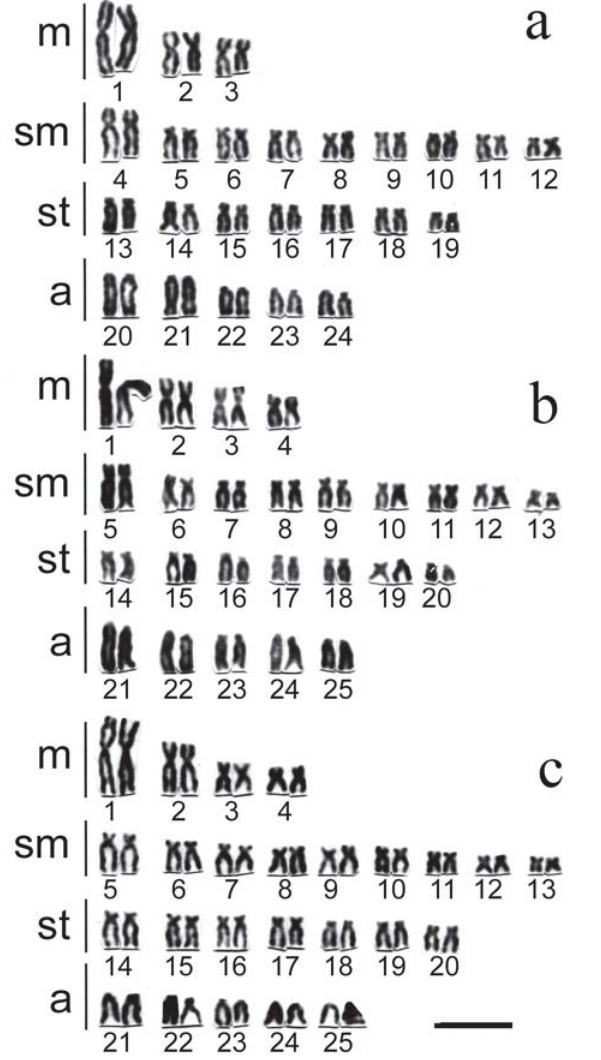
Fig. 2. Conventional karyotypes found in Astyanax aff . fasciatus of the upper rio Tibagi region (Ponta Grossa, Paraná State, Brazil). In (a), cytotype A (2n=48 chromosomes), in (b) cytotype B (2n=50 chromosomes) and in (c) cytotype C (2n=50 chromosomes). Bar: